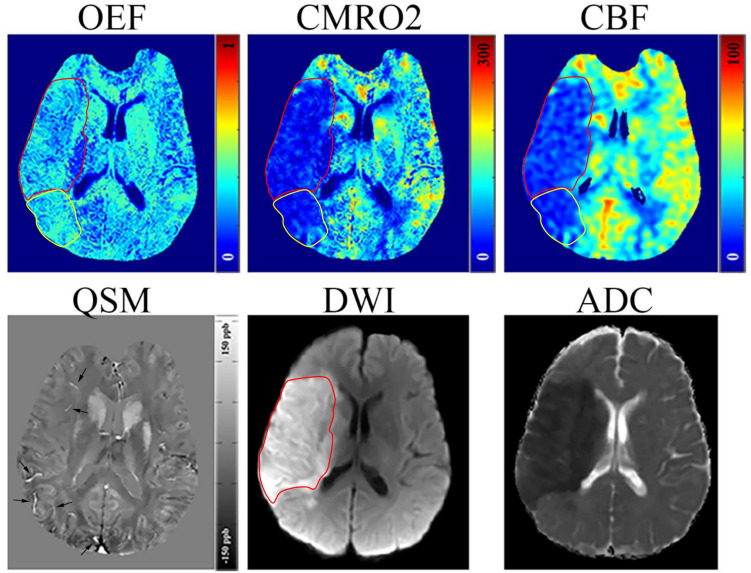
Representative images of an acute ischemic stroke patient with 18 h between MRI examination and stroke symptom onset. The ischemic lesion was caused by the occlusion of the right middle cerebral artery. The ischemic core (red circle) identified on diffusion weighted imaging (DWI) and apparent diffusion coefficient (ADC) maps manifested as a slight decrease (30.38%) in oxygen extraction fraction (OEF) by comparing to the contralateral region (32.12%); some scattered dots within the ischemic core showed a higher OEF. A mismatch (yellow circle) is seen between the cerebral blood flow (CBF) and DWI maps near the ischemic core showing a relatively high OEF (32.15%), slightly higher than the contralateral region, which may represent salvageable ischemic tissue or benign oligemia tissue. Both the ischemic core and mismatch region showed a decrease in cerebral metabolic rate of oxygen (CMRO2). On the quantitative susceptibility mapping (QSM) map, some hyperintense veins (arrow) can be seen surrounding the ischemic core.